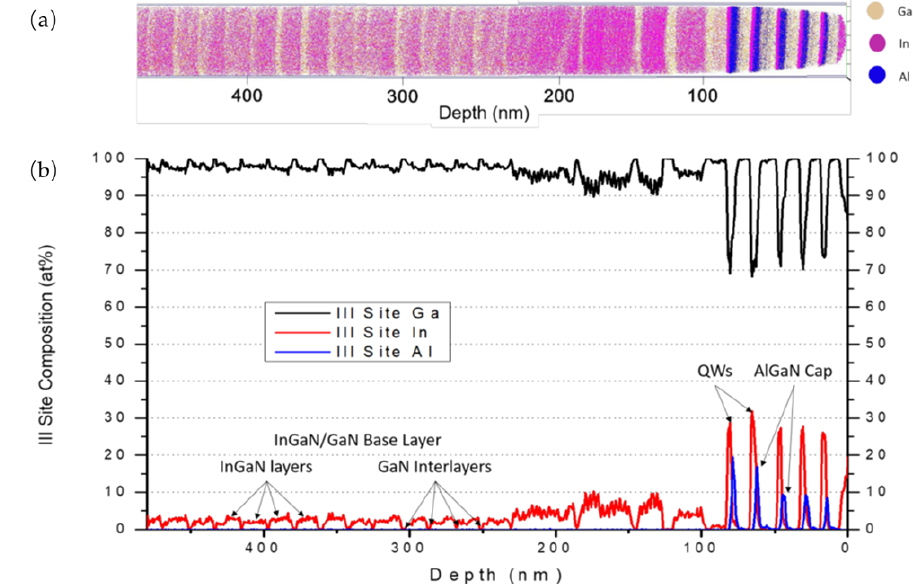
Figure 4. ( a ) Reconstruction of the analyzed APT tip for III-site atoms. ( b ) Corresponding group-III composition profile of the sample in atomic